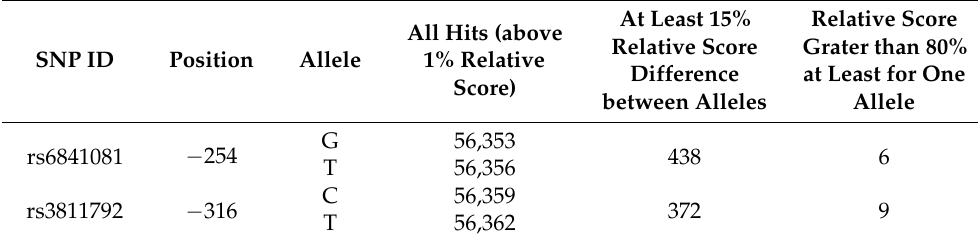
Table 1. Three-step transcription factor binding site screening. The position of SNPs is counted upstream from the ATG start codon.